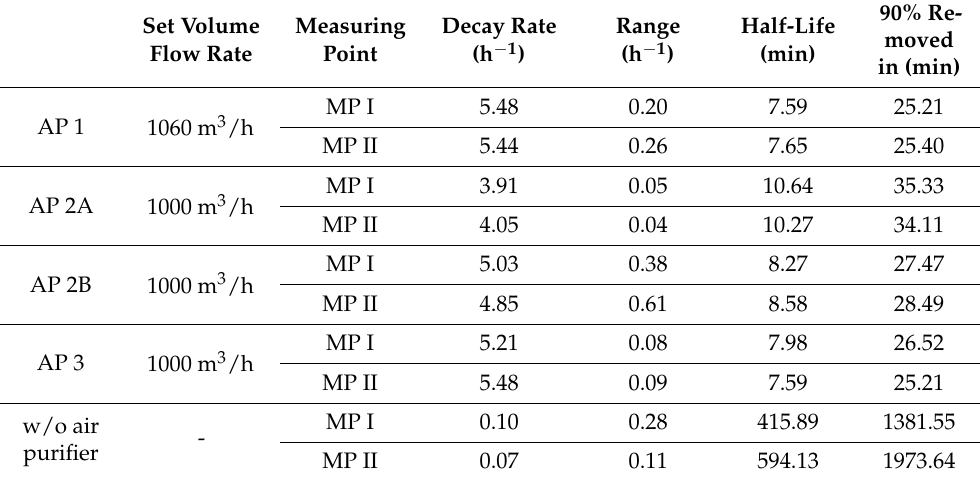
Table 2. Values of the decay rates, half-life, and time after 90% of the aerosols have been removed for different APs at a set volume flow of around 1000 m 3 /h and without AP considering two different measuring points as shown in Figure